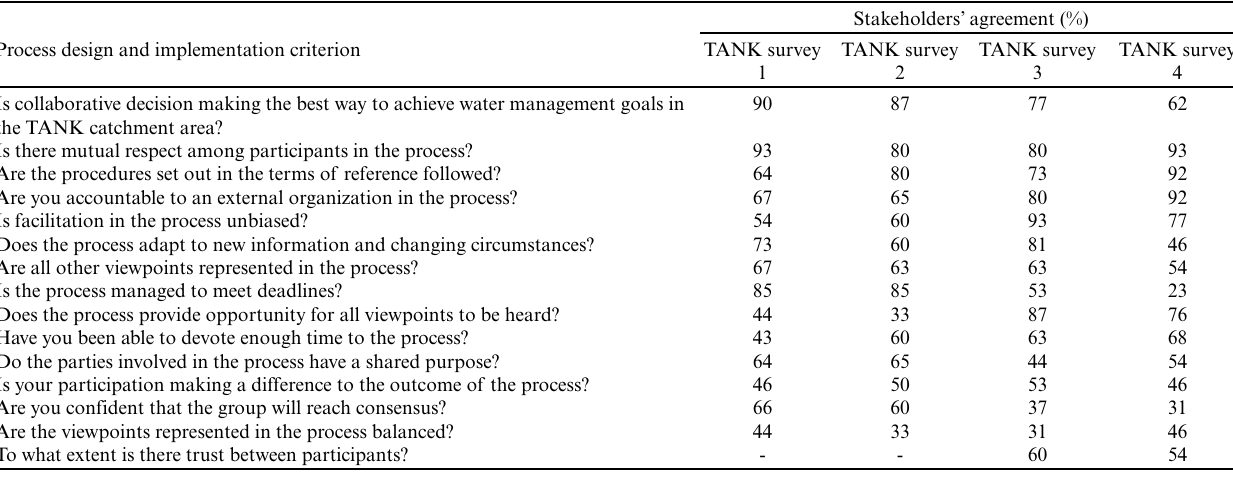
Table 5 . Process design and implementation criteria and stakeholders’ agreement. The percentage figure in some cases represents the average from several questions and/or statements used to evaluate a single criterion. Each criterion was prefaced with “To what extent...” Note: TANK = T ū taekur ī , Ahuriri, Ngaruroro, and Karam ū